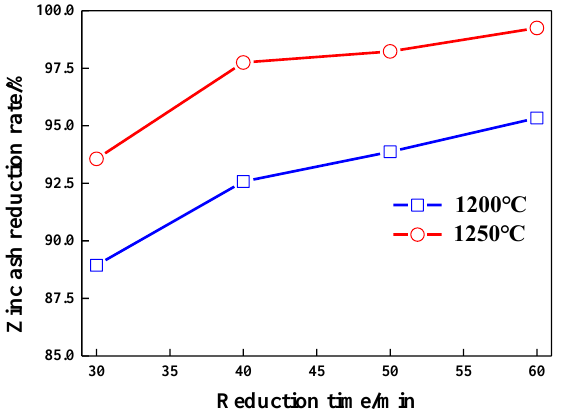
Figure 7. Effect of time on reduction rate of zinc ash.